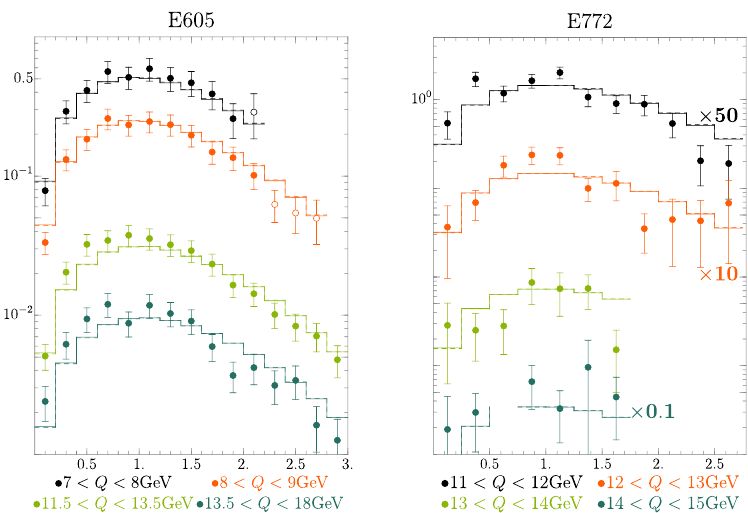
Figure 16 . Di(cid:11)erential cross-section of DY process ( d(cid:27)=dq T [fb/GeV] vs. q T [GeV]) measured by E605 and E772 at di(cid:11)erent values of s and Q . The solid (dashed) lines are the theory prediction at NNLO (N 3 LO) shifted by the average systematic shift (see table 8). Filled (empty) point were (not) included in the (cid:12)t of NP parameters. For clarity the data of E772 is multiplied by the factors indicated in the plot.